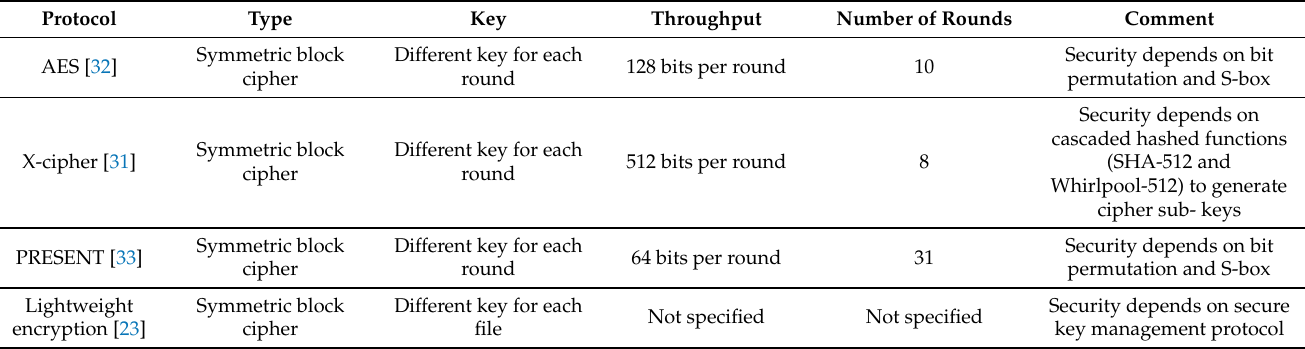
Table 2. Comparison between X-cipher, AES, PRESENT, and lightweight